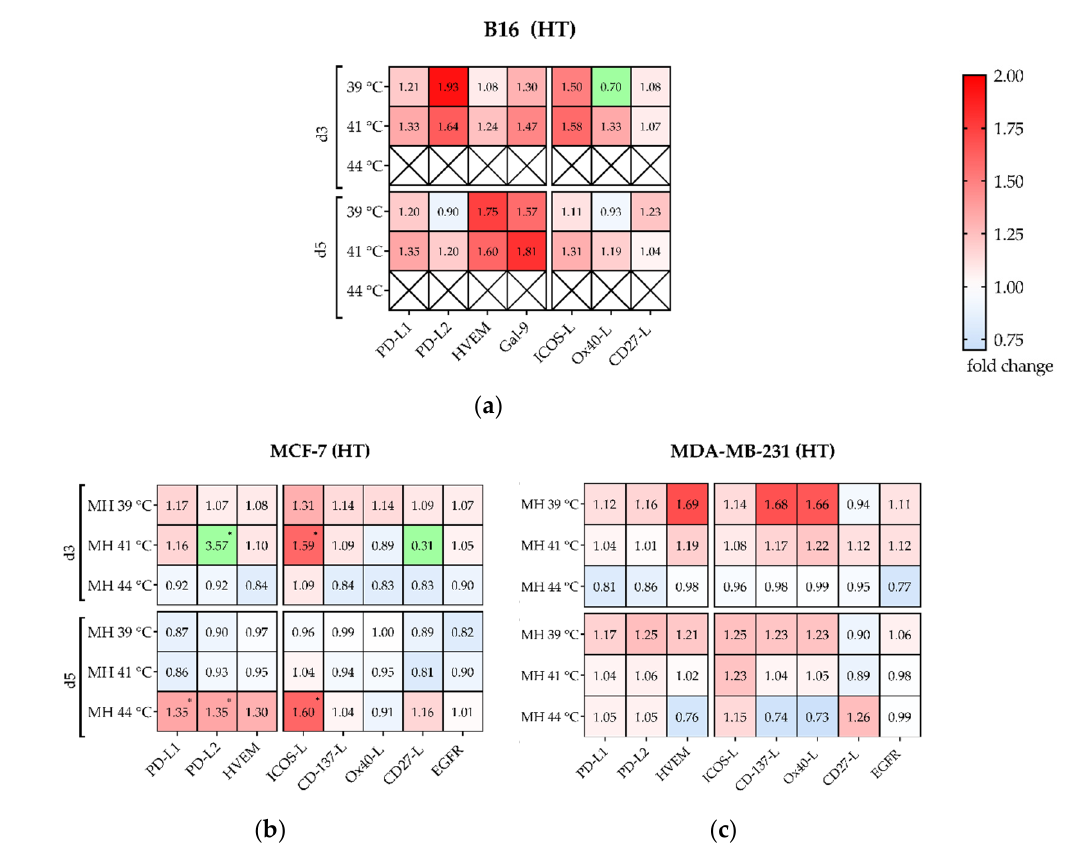
Figure 10. Heatmap of normalized expression (change in mean fluorescence intensity compared to mock-treated cells) of immune checkpoint molecules and of EGFR on day 3 ( d 3) and day 5 ( d 5) on the cell surface of ( a ) B16 melanoma; ( b ) MCF-7 breast cancer and ( c ) MDA-MB-231 breast cancer cells after 915 MHz hyperthermia at 39 °C, 41 °C or 44 °C. Green boxes are values of ∆ MFI < 0.75 or > 2.0. Significance test was conducted using Kruskal-Wallis test with corrected Dunn’s multiple comparison from three independent experiments, each measured in duplicates. * ( p < 0.1).